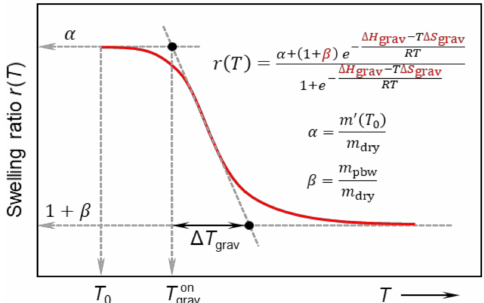
Figure 2. Theoretical dependence of swelling ratio r ( T ) as defined by Equation (16) (also present in the graph). The essential features of the curve are shown, including fitted parameters highlighted by red